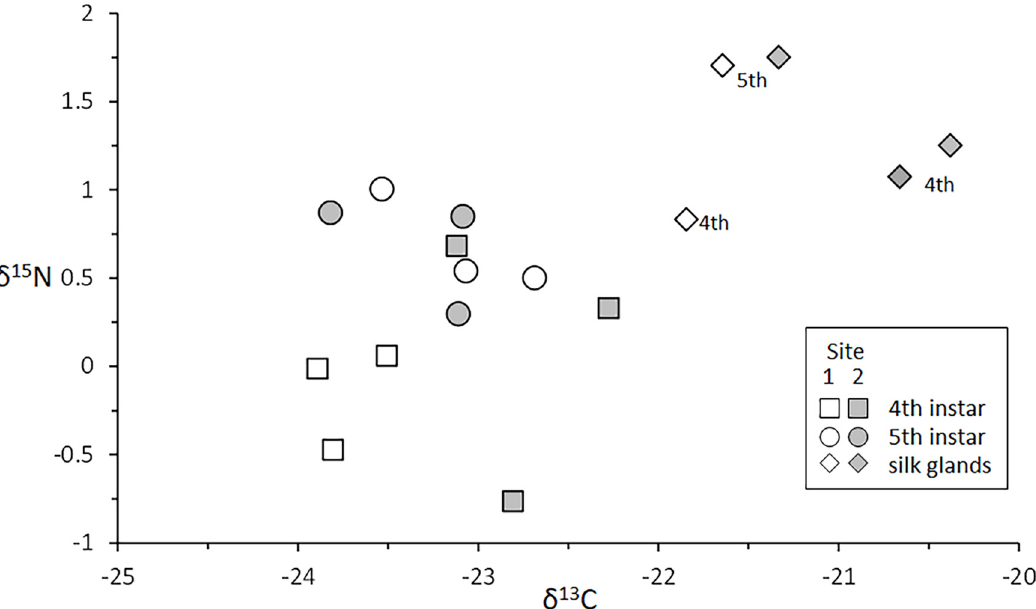
Figure 13. δ 13 C and δ 15 N data for 4th and 5th instar larvae and their silk glands from Sites 1 and 2. Numbers next to silk gland values indicate larval instar associations.